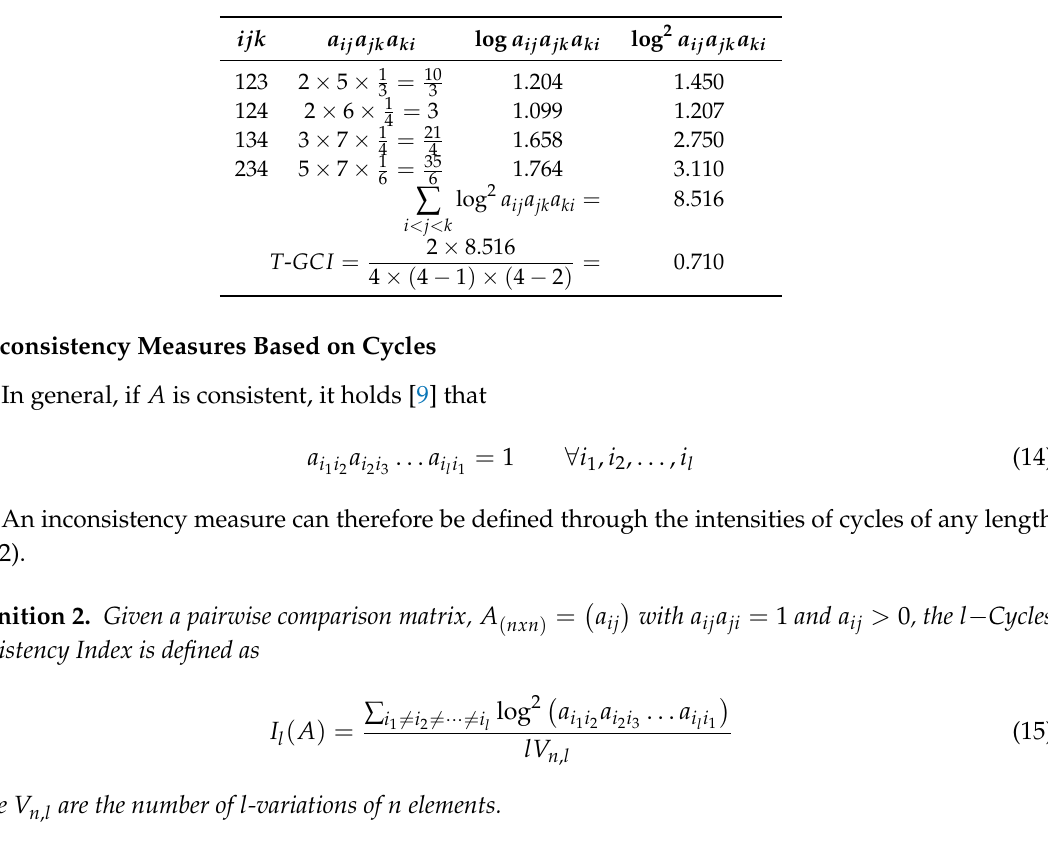
Table 4. Calculation of the T - GCI